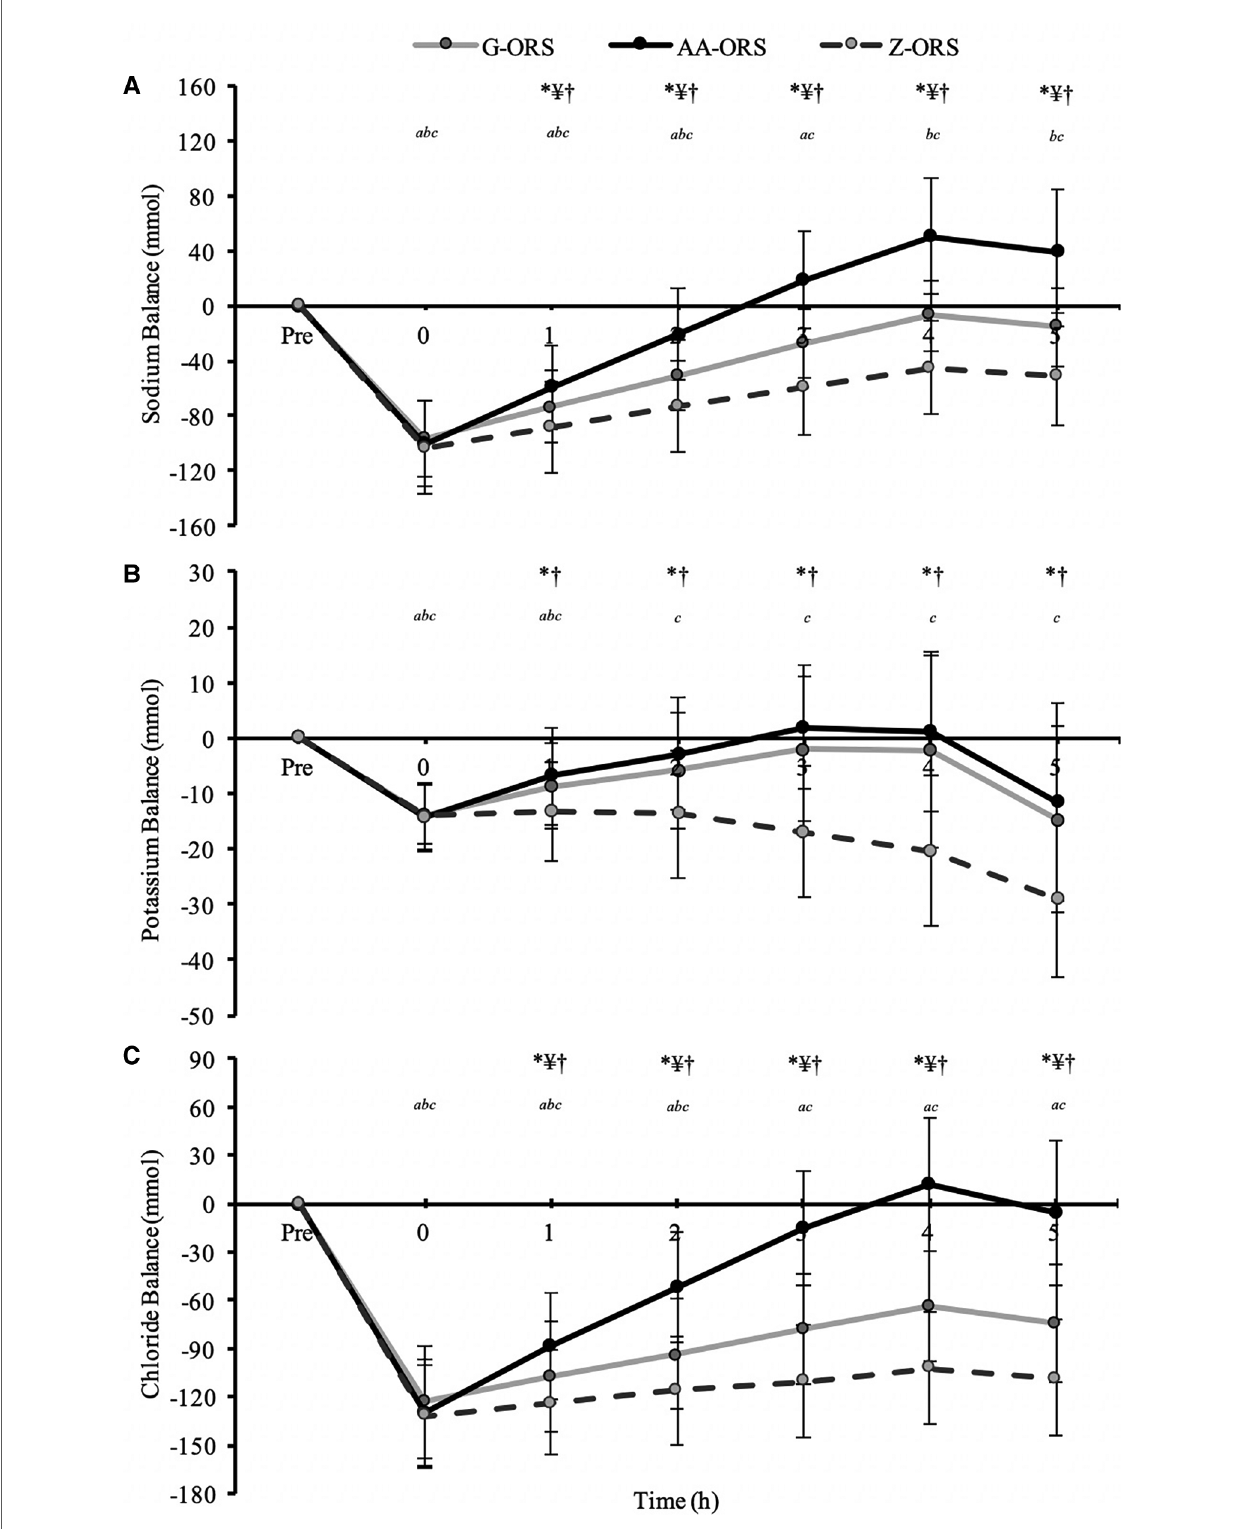
FIGURE 6 Electrolyte balance data from baseline (Pre) and during the rehydration phase. ( A ) Sodium; ( B ) , Potassium; ( C ), Chloride. P <0.05: *, AA-ORS greater vs. Z-ORS; ¥, AA-ORS greater vs. G-ORS; † , G-ORS greater vs. Z-ORS; a , G-ORS different vs. baseline, b , AA-ORS different vs. baseline; c , Z-ORS different vs.